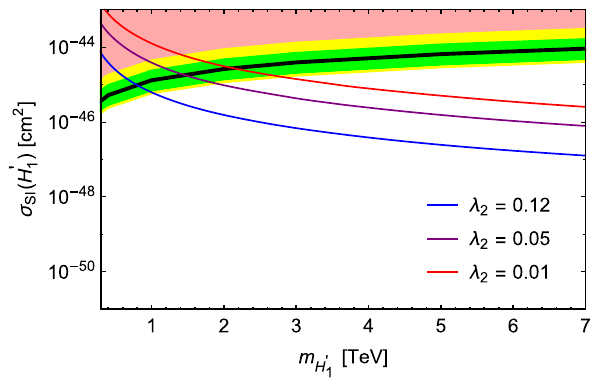
Fig. 4 The SI DM-nucleon scattering cross-section limit as a function of DM mass according to the several choices of λ 2 , where the excluded region (light red) lies above the experimental (green and yellow) bands